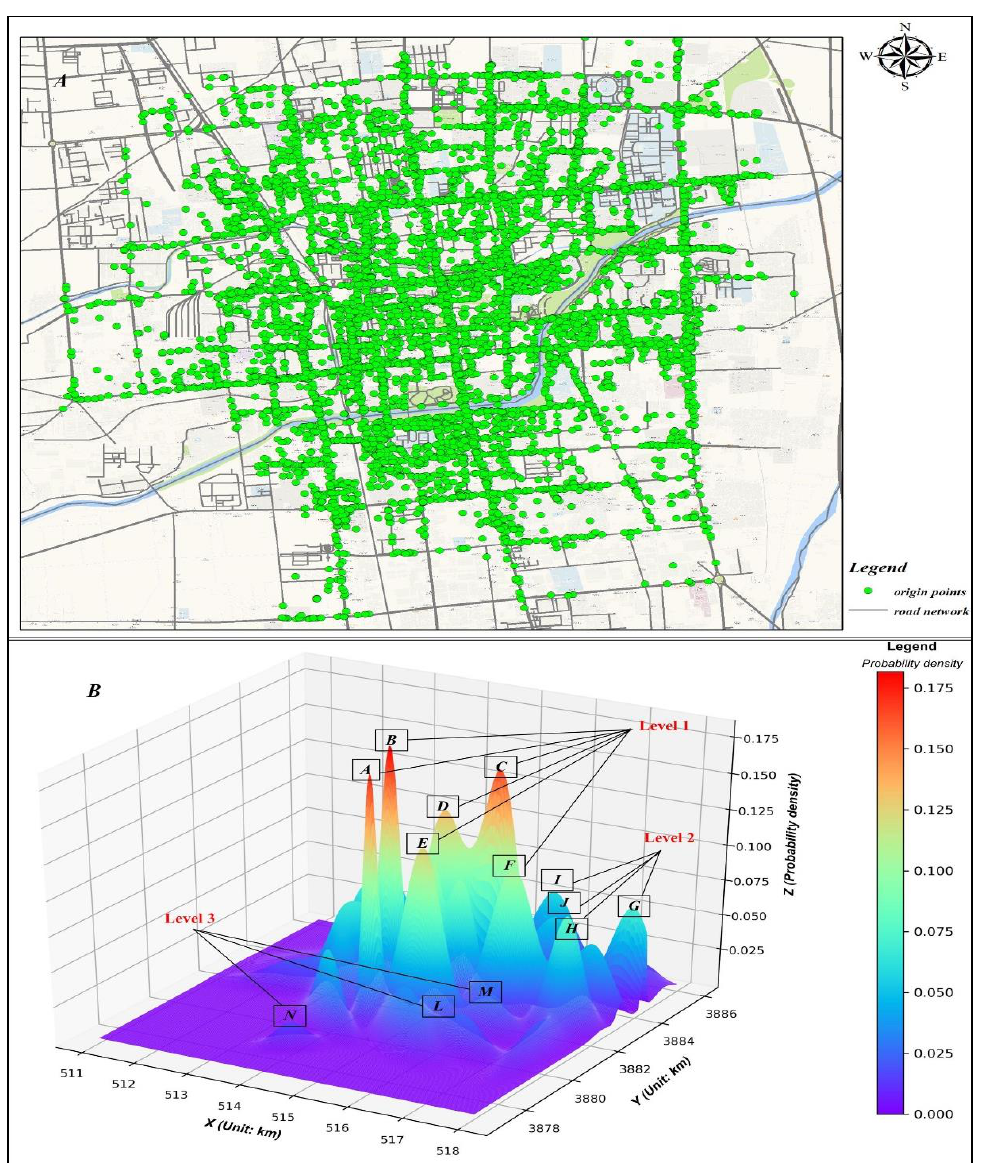
Figure 5. Distribution of the origin points during morning rush hours. Part A shows the discrete distribution of the origin points of trips in the morning rush hour period. Part B is the simulation results of the Gaussian mixture model (GMM). A to N denote Gaussian components with different shapes, reflecting the nonuniform point density.